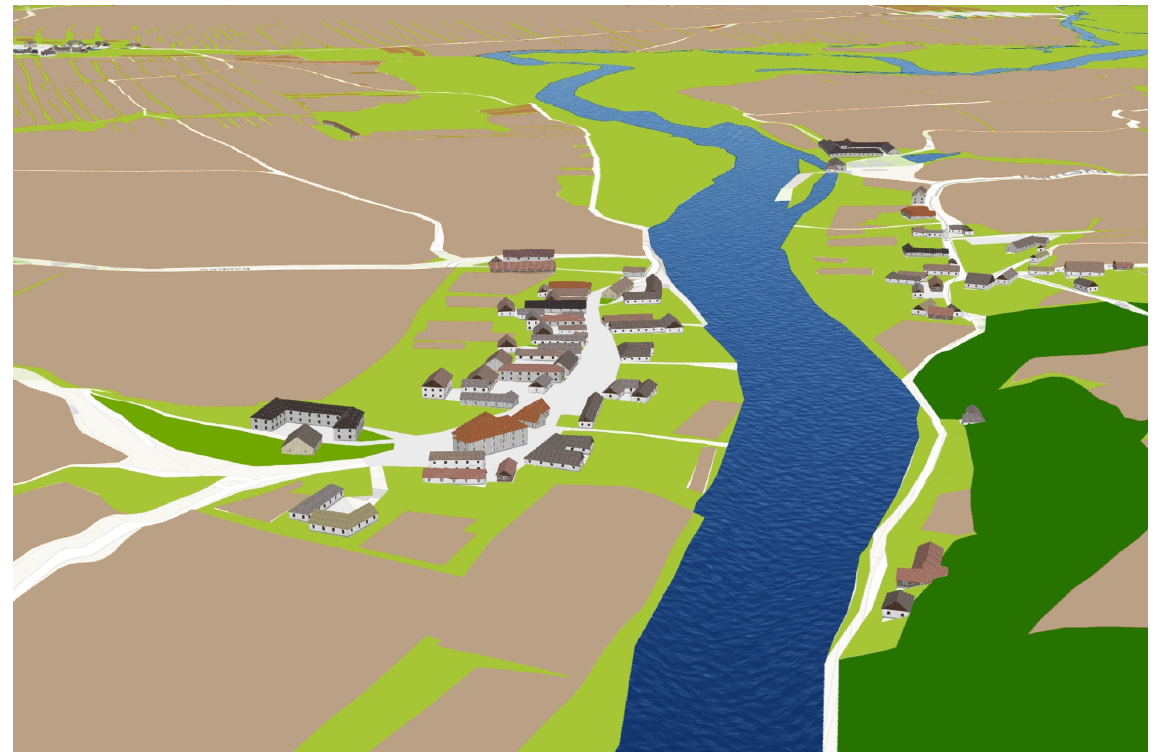
Figure 3. Virtual landscape with procedurally modeled built-up areas, Source: author’s elaboration.